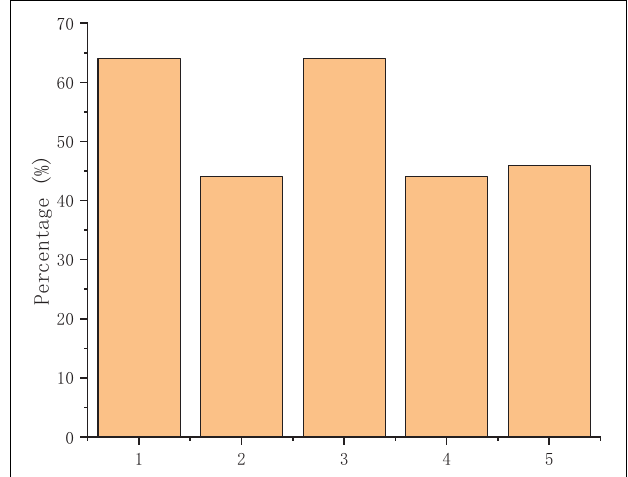
FIGURE 9 | Factors affecting hybrid learning [(1) a weak correlation between network resources and courses; (2) unavailable to online learning; (3) insufficient time; (4) heavy tasks assigned by teachers; and (5) inconvenient to use the Internet].